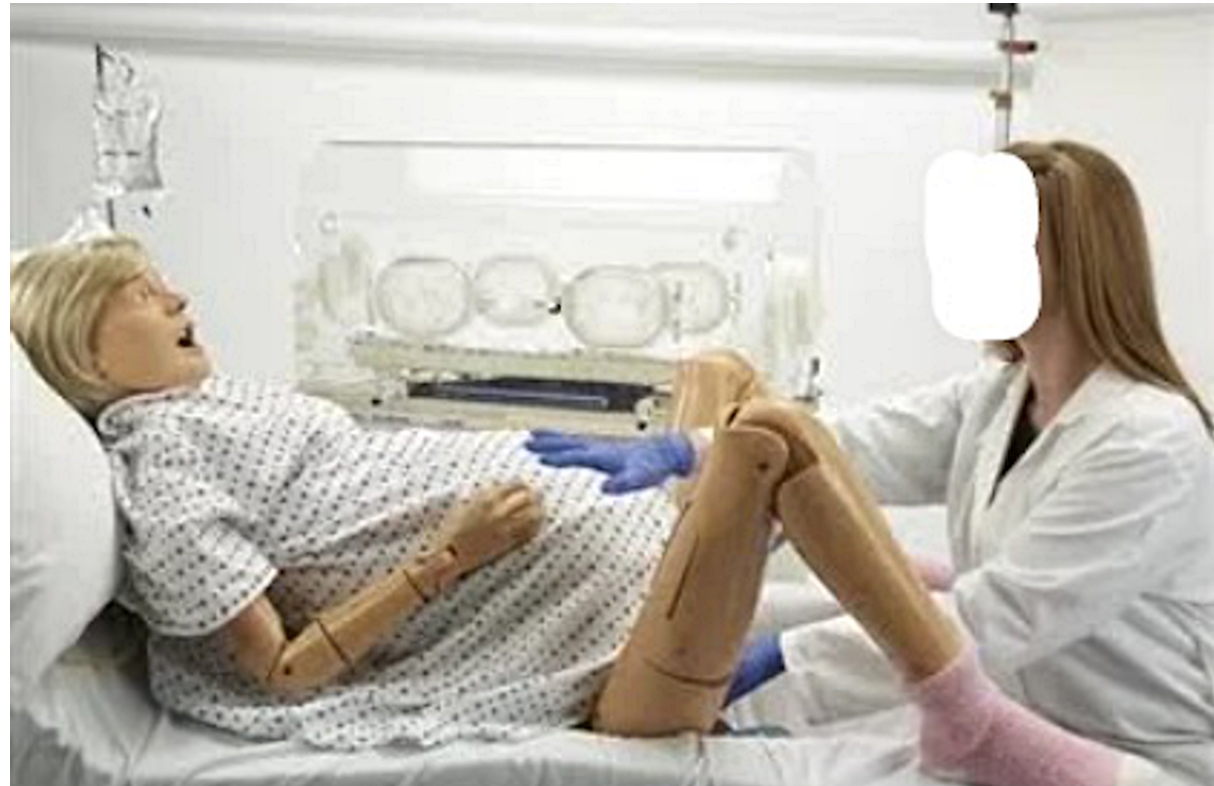
Figure 1. NOELLE S550 Maternal and Neonatal Birthing Simulator